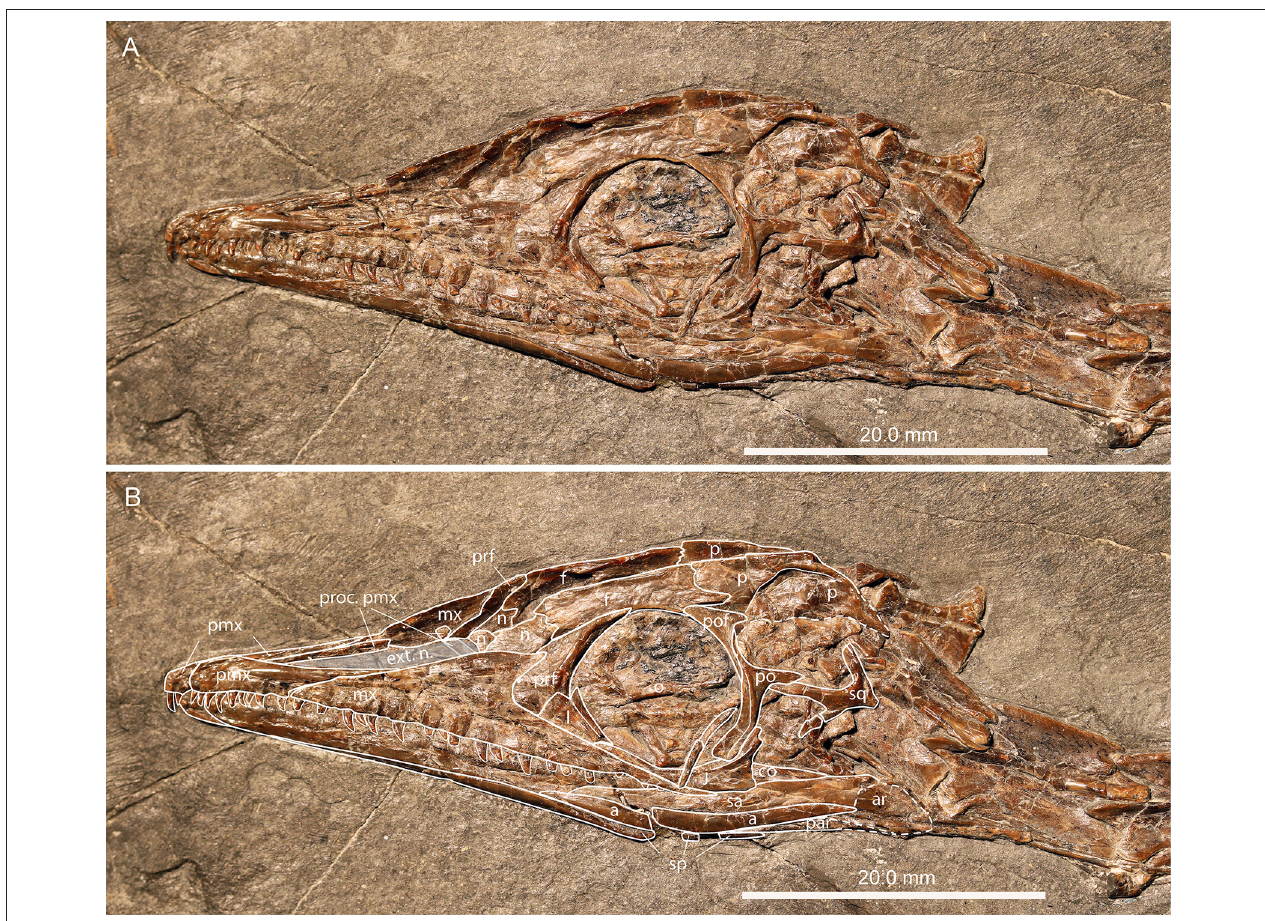
FIGURE 10 | Skull of specimen PIMUZ T 4822 of Macrocnemus bassanii . (A) Photograph; (B) interpretative drawing